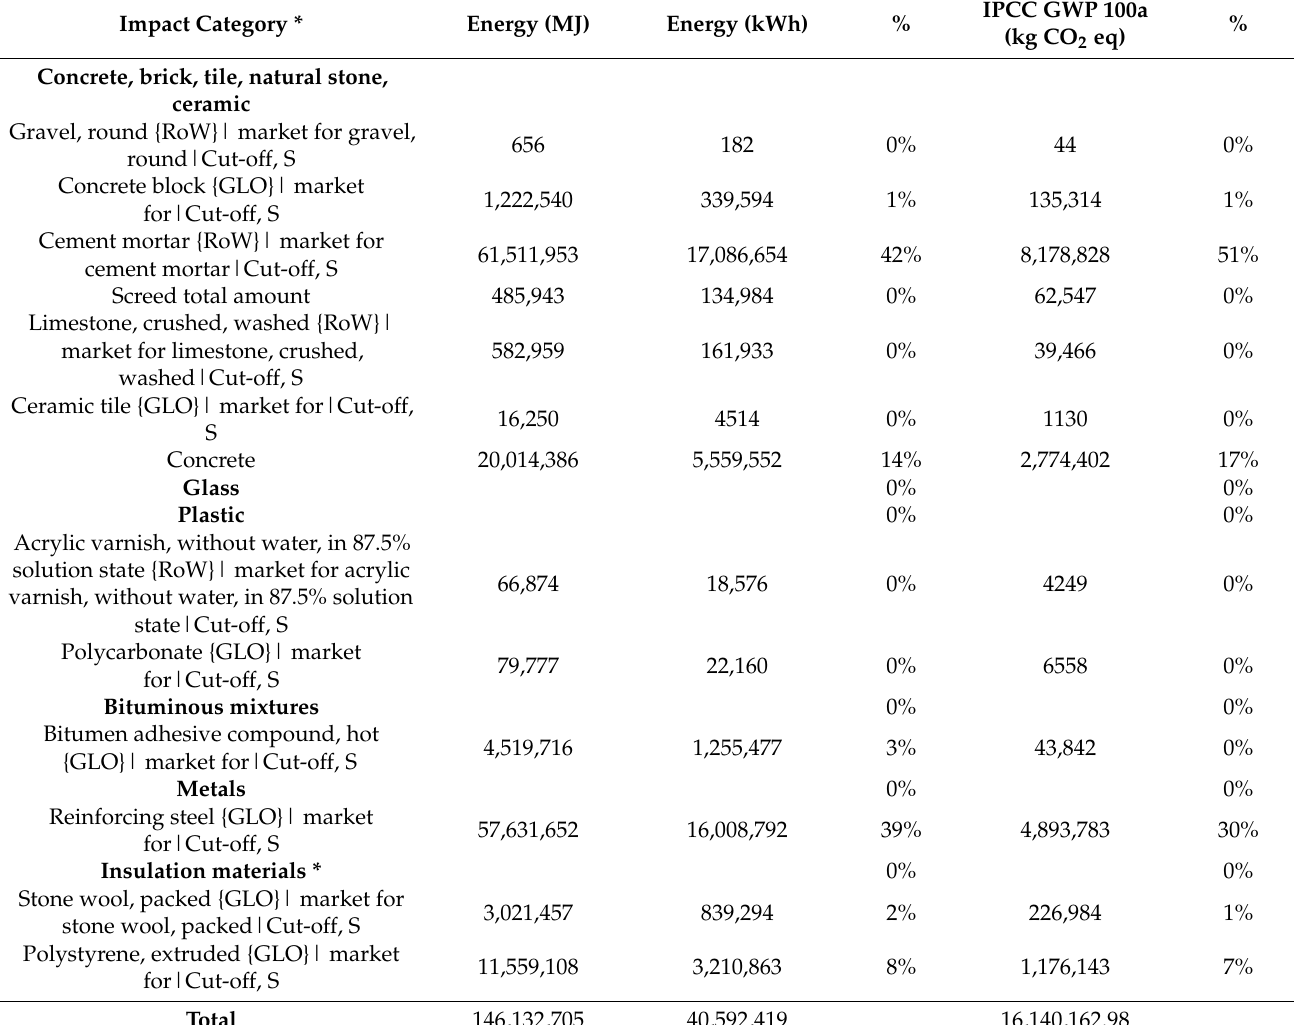
Table 4. Impact categories of shell building elements by material type in terms of primary energy demand (in MJ and kWh) and GWP (in kg CO 2